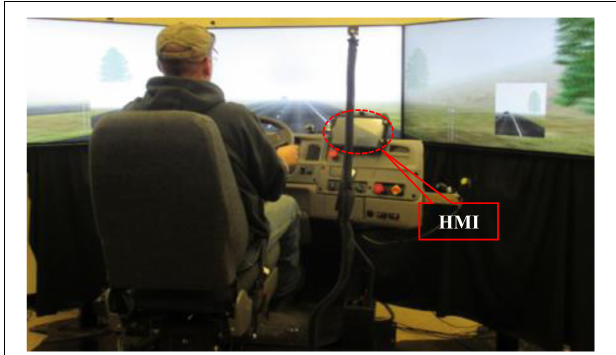
FIGURE 2 | Truck simulator with CV